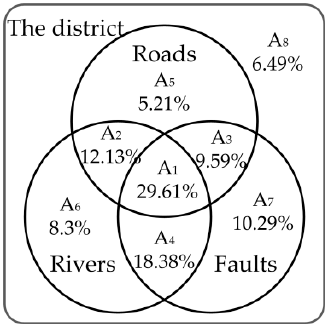
Table 5. Contribution indices of influence factors.